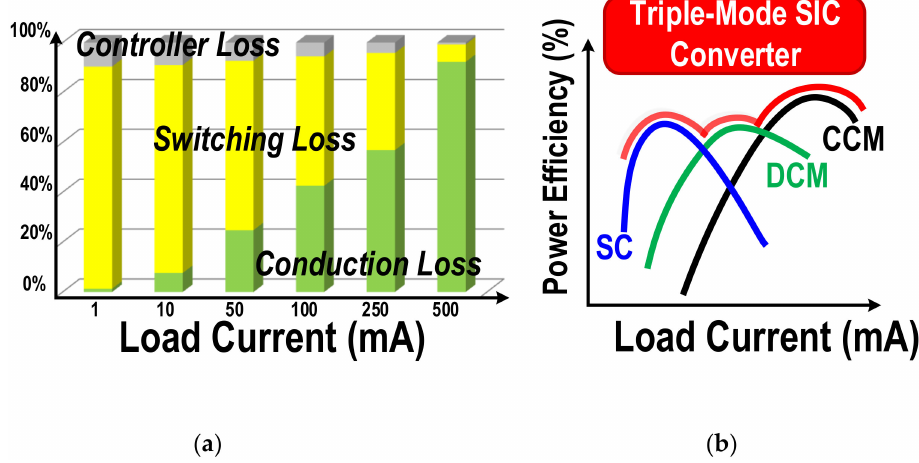
Figure 1. ( a ) Ratio of power losses in the switching type power converter with di ff erent load current conditions and ( b ) e ffi ciency comparison plot in a di ff erent mode of the